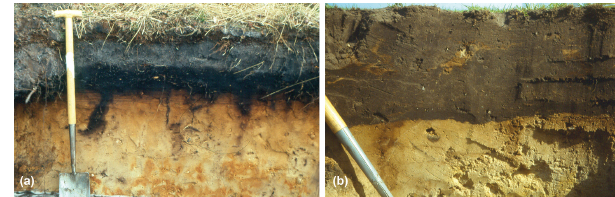
Figure 1. Destruction of soil archives on the Maashorst (North Bra- bant) during the transition of (former) heaths into modern arable fields. Left: undisturbed gleyic podzol; right: deeply ploughed pod- zol.